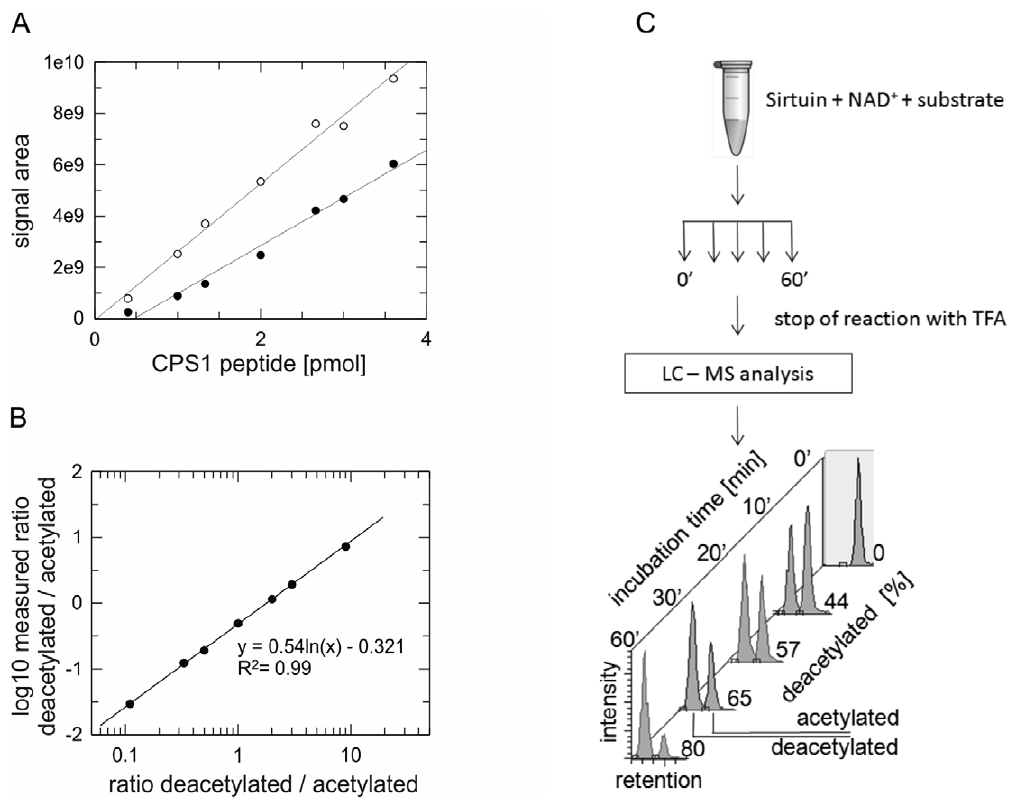
N Figure 1. Development of a label-free, quantitative mass spectrometry-based deacylation assay. ( A ) Different amounts of acetylated ) CPS1-Lys527 peptide are plotted against their respective mass spectrometry signal areas. Interpolations (lines) show the ( # ) and deacetylated ( N linear correlations between peptide amounts and detected signals, and the slightly different slopes for the two peptide species. ( B ) Ratios of the ). Equation and correlation for injected amounts of deacetylated and acetylated peptide plotted against ratios of the measured log 10 signal areas ( the linear interpolation (line) are indicated. ( C ) Scheme for the mass spectrometry-based deacylation assay. Percent deacetylation is calculated by normalizing the product area to the total signal area, and deacetylation rates are determined through analysis of aliquots taken after different incubation times. doi:10.1371/journal.pone.0045098.g001 difference in nicotinamide sensitivity. Similarly, K d values for NAD + under peptide saturation were comparable for Sirt3 (0.26 6 0.15 mM) and Sirt5 (0.20 6 0.07 mM; Fig. S2B). Thus,